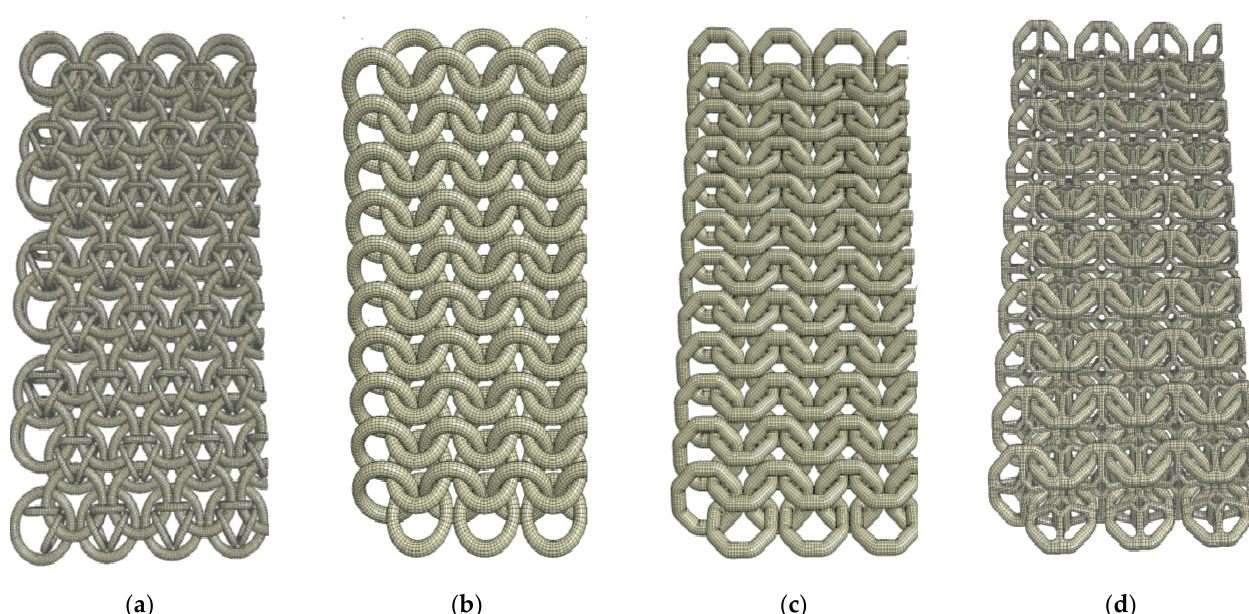
Figure 1. Variants of 3D printed titanium structures chosen for analyses: ( a ) structure of the S1 type; ( b ) structure of the S2 type; ( c ) structure of the S3 type and ( d ) structure of the S4 type. The analyzed ballistic inserts had dimensions of 100 × 100 mm and a sandwich form (Figure 2). Each variant of titanium structure was placed between layers of Twaron CT 750 aramid fabric (two layers behind and two layers in front of the structure).